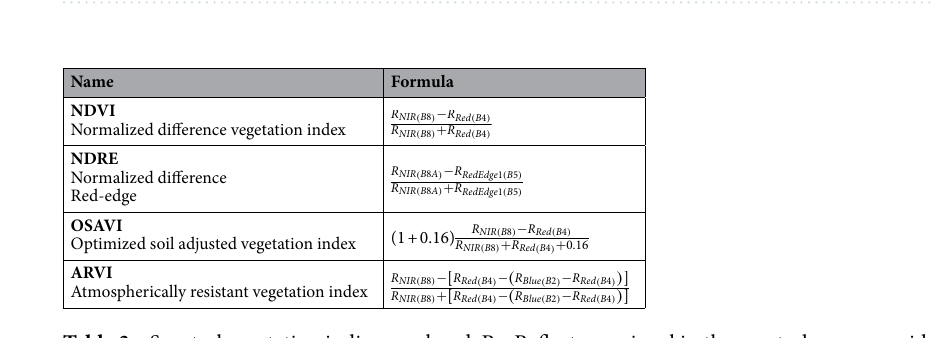
Table 3. Spectral vegetation indices analysed. R = Reflectance signal in the spectral range considered: the corresponding S-2 bands are reported in brackets.